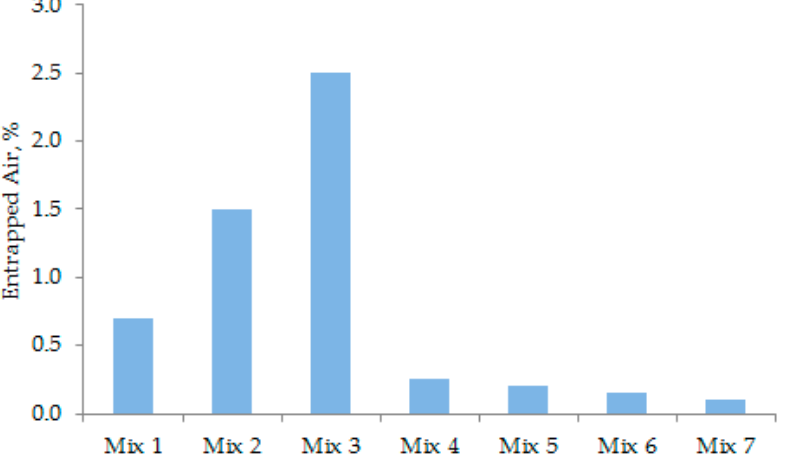
Figure 8. Entrapped air content of different concrete mixes.